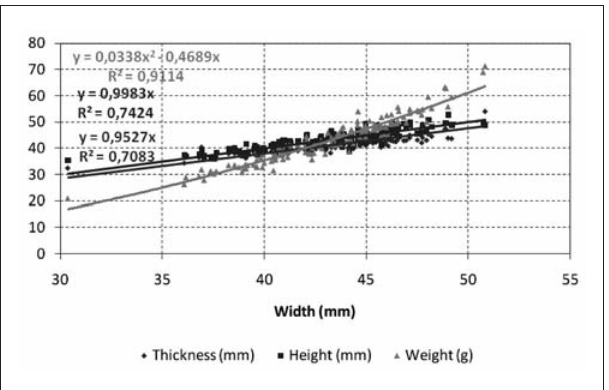
Fig.24: The connection of the measured data with the width for Bergerouge apricot